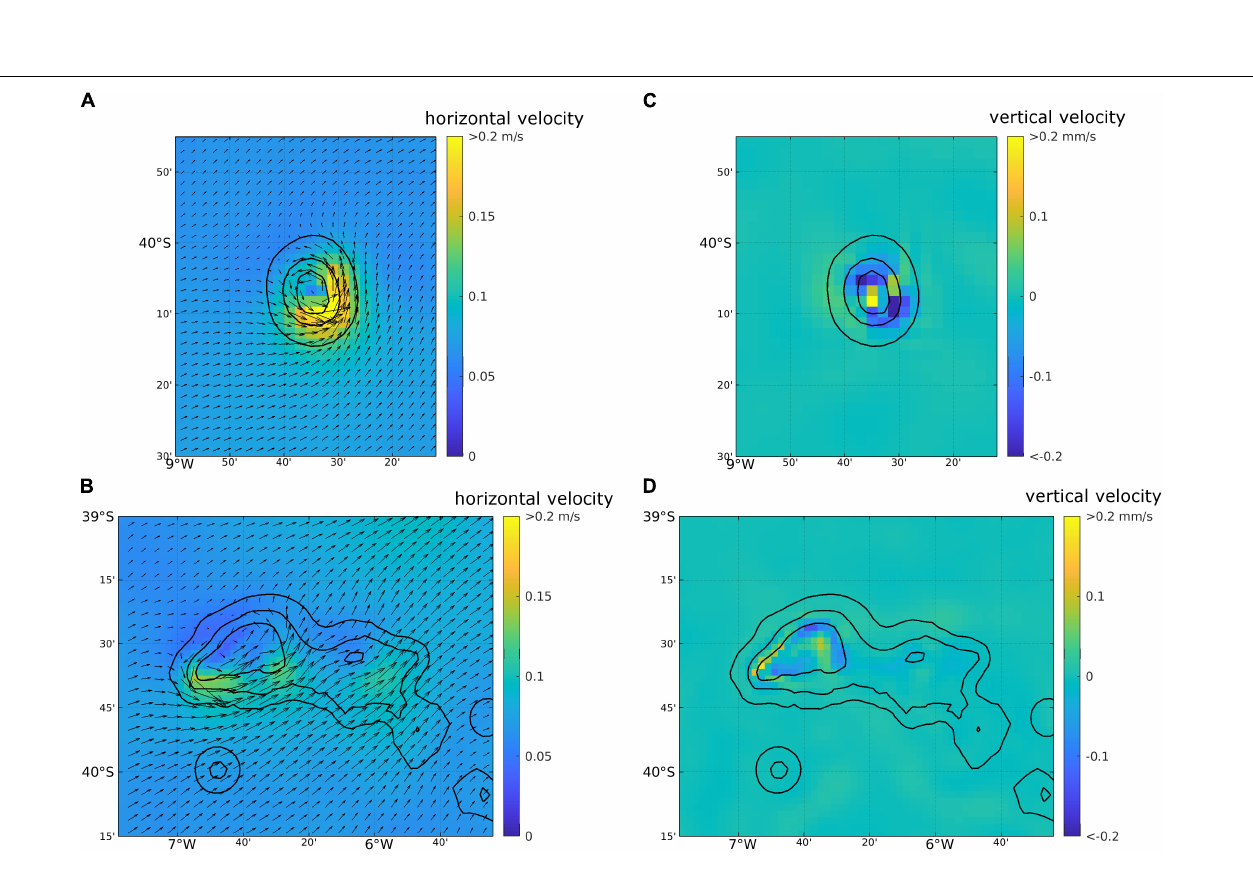
FIGURE 9 | Simulated 10-year mean horizontal velocities (A,B) and vertical velocities (C,D) at 10 m depth from the regional oceanographic model: McNish seamount (A,C) , RSA seamount (B,D) . Vectors in (A,B) indicate the direction of flow [every 2nd flow vector shown in (B) ], and shading represents current